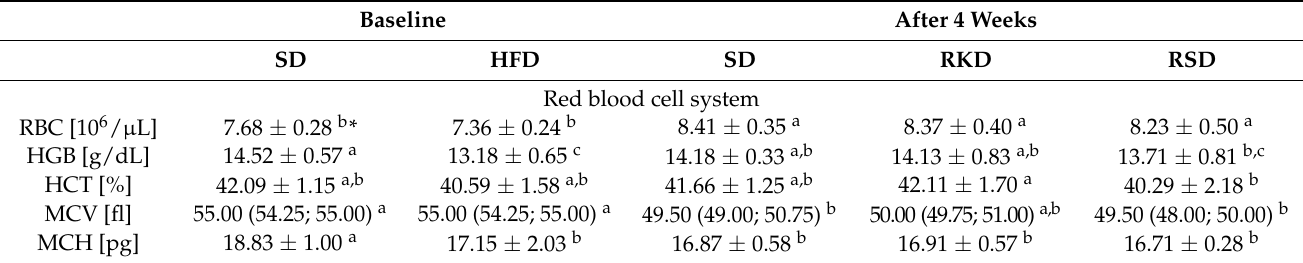
Figure 2. The changes in the body weight, weight gain, percentage of lean and fat mass during 4 weeks of KD or control diet. The p -values of the two-way ANOVA analysis are presented in Table. Table 1. Haematological parameters of blood before and after the intervention. Quantitative variables with a normal distribution are expressed as mean ± SD; quantitative variables which showed a non-normal distribution are expressed as median (Q1;